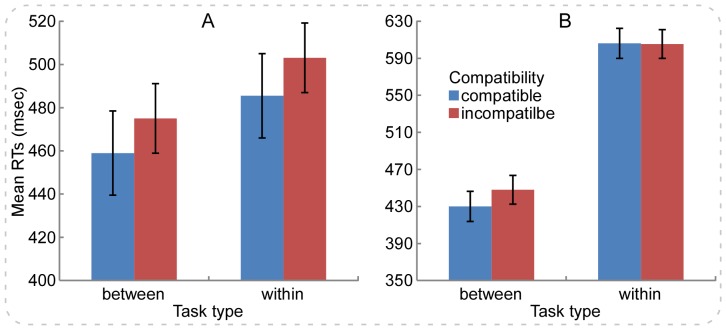
The RTs results for Experiment 3.Panel A illustrates the RTs results for Experiment 3A with the between-category color task preceding the within-category color task. It is notable that the Simon effect is clearly observed and the RTs levels are similar in both tasks. Panel B illustrates the RTs results of Experiment 3B with the with-category color task preceding the between-category color task. Similar to Experiments 1 and 2, Experiment 3B reveals significant Simon effect in the between-category but not within-category tasks. Error bars indicate ±1 SEMs as calculated by the pairwise difference method (SEMpairedDiff) [39].